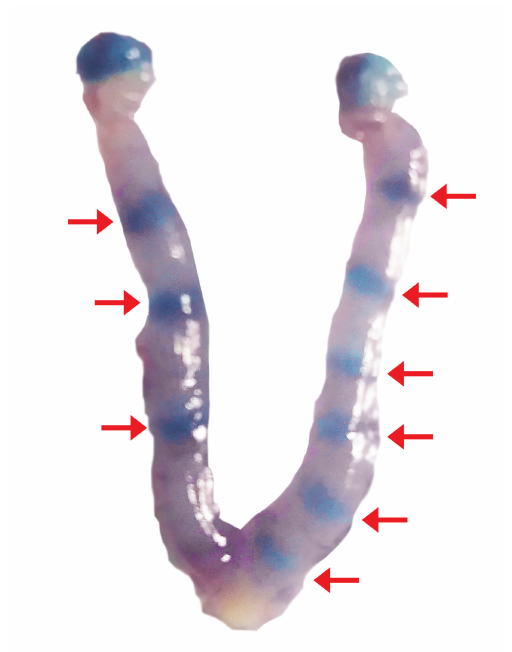
Figure 1 - Embryo implantation sites on the mice uterine horns at the fifth day of pregnancy using Chicago blue dye; the arrows indicate